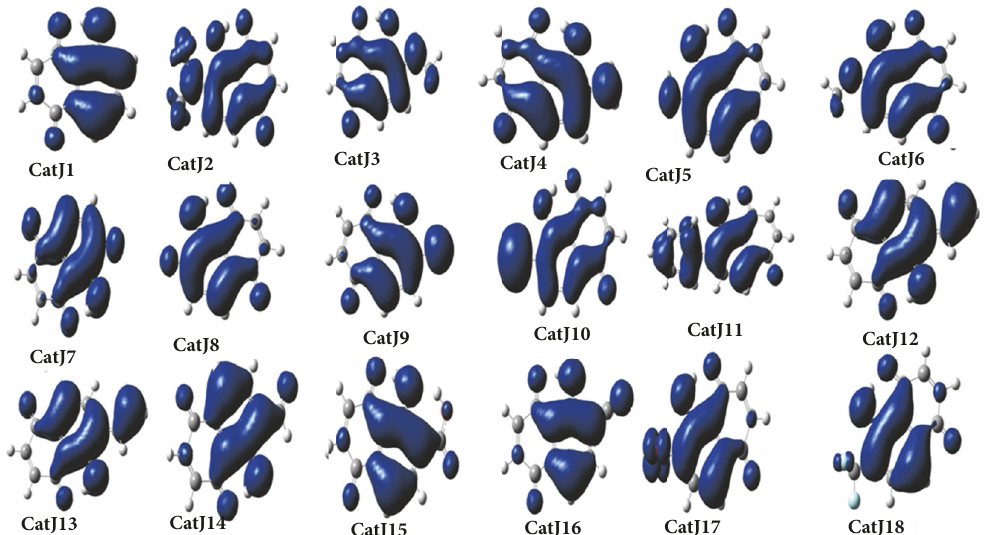
Figure 4: Plots of spin density for various hydrogen atom-abstracted cation radicals of juglone and derivatives.